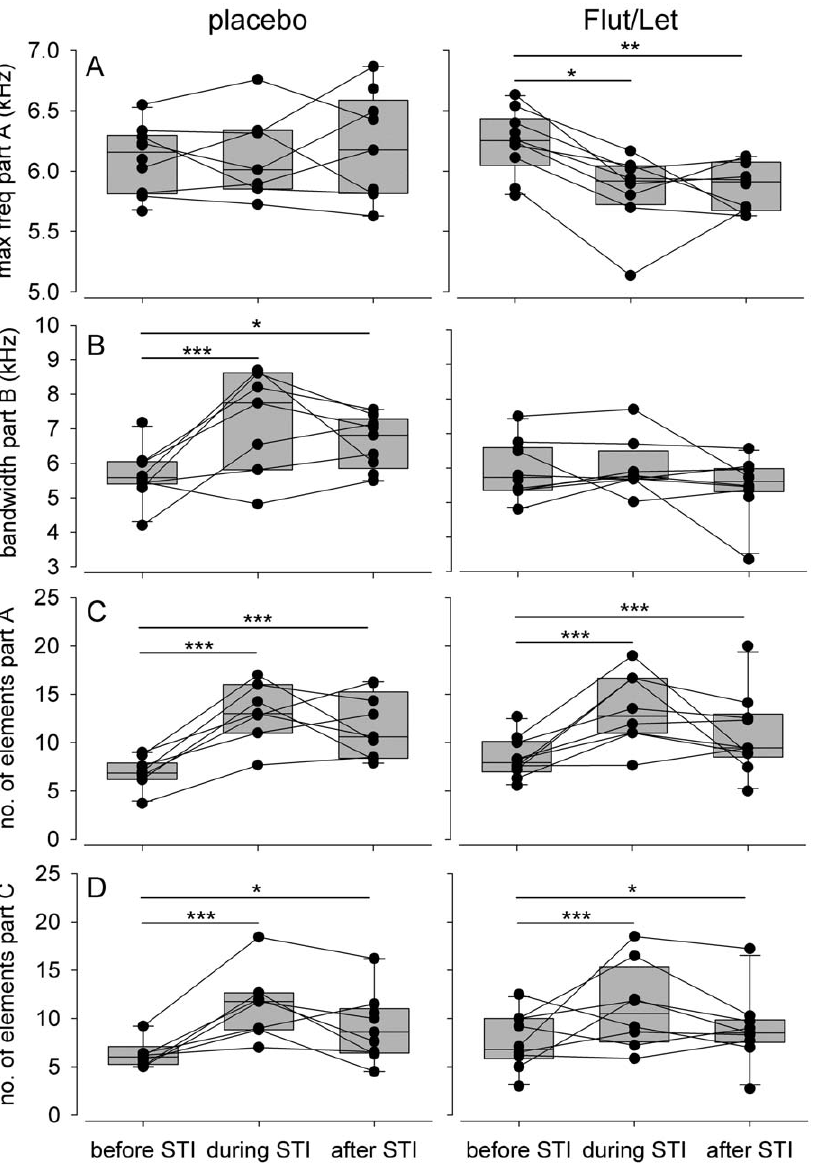
male are connected by a line. Asterisks indicate significance (* p , 0.05, ** p , 0.01, *** p , 0.001) and are according to a priori set contrasts (before vs. STI and before vs. after the